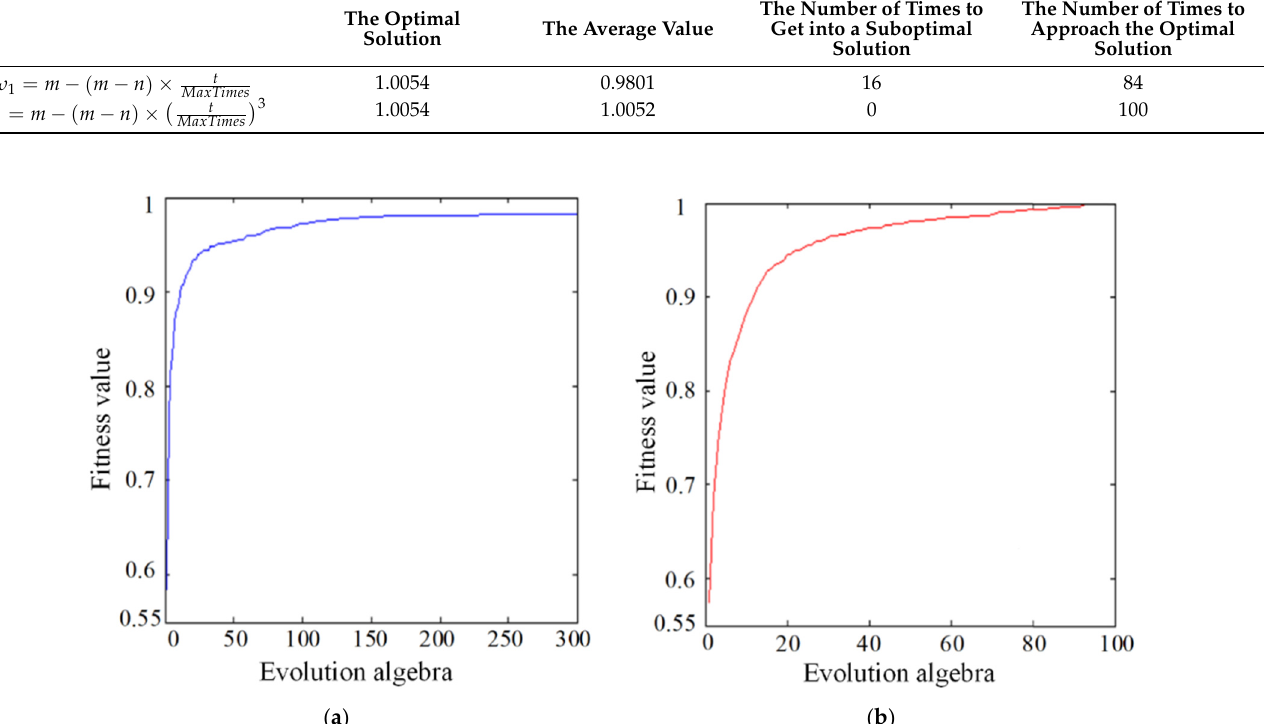
Table 2. Performance comparison of different inertia weights.